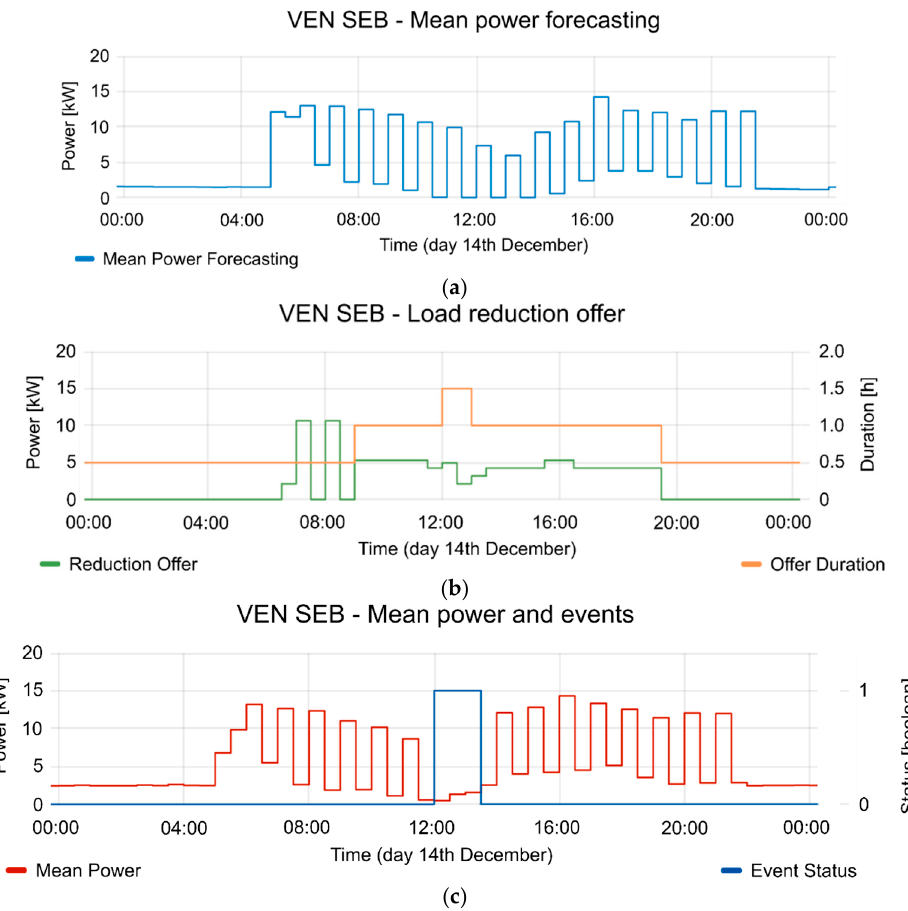
Figure 22. Detailed information from 14 December event. ( a ) mean power forecasting; ( b ) reduction offer and offer duration; ( c ) mean power and event status (where 1 is active and 0 is inactive).